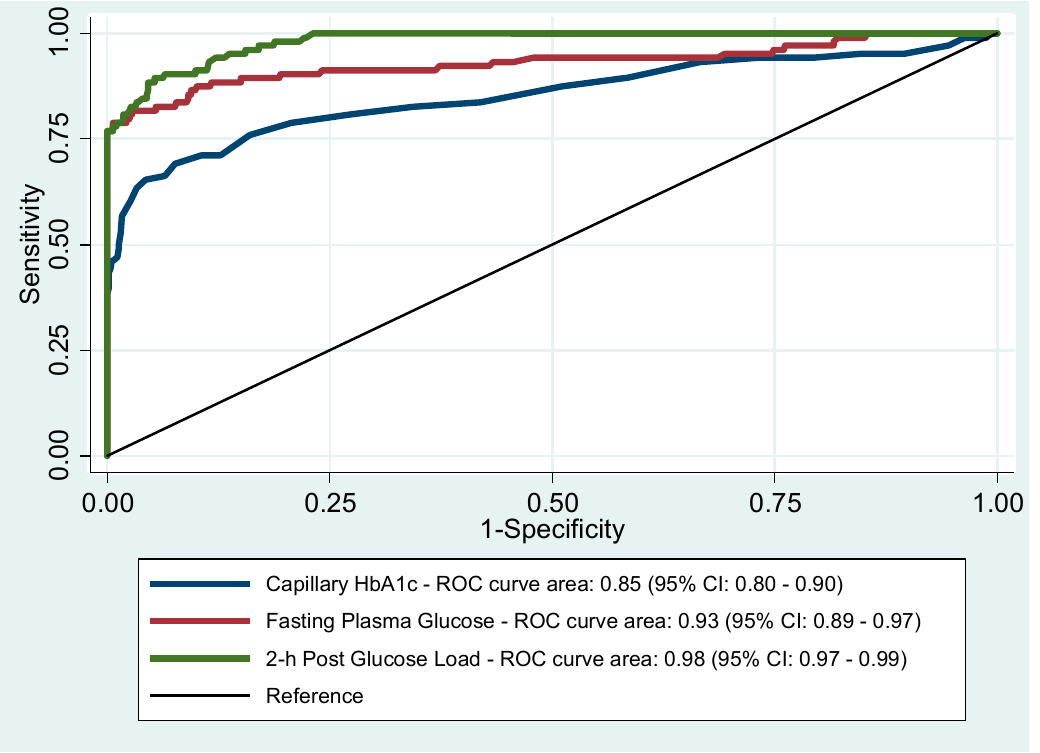
Figure 3. Receiver operating characteristics curves (ROC) for HbA1c, fasting plasma glucose (FPG), and 2 h post-glucose load to diagnose diabetes.